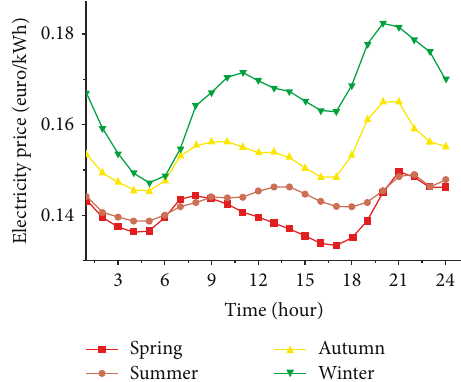
Figure 13: Daily electricity price for di ff erent